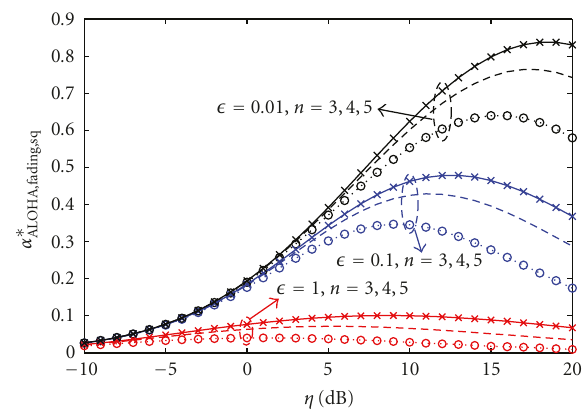
Figure 7: The p t -optimal α ALOHA,fading,sq in bits-meters/s/Hz/node versus η for the square topology under SNR 0 = 30dB and ρ = 1.